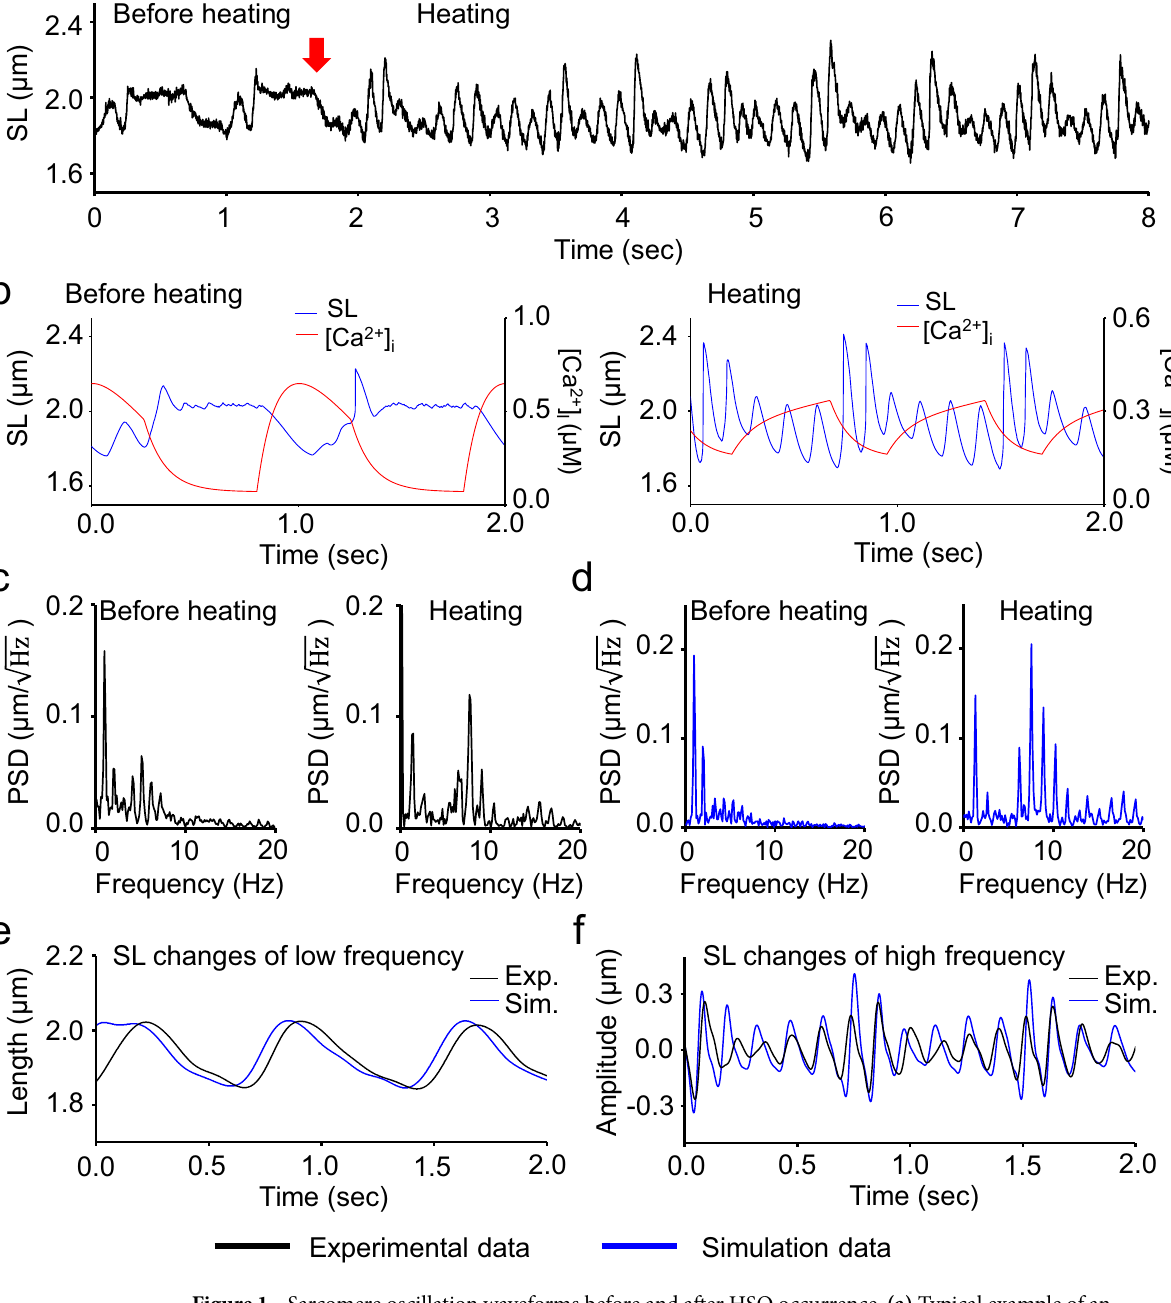
Figure 1. Sarcomere oscillation waveforms before and after HSO occurrence. (a) Typical example of an oscillation waveform of sarcomere length (SL) in cardiomyocytes. The infrared laser was activated at the time indicated by the red arrow. HSOs occurred promptly after irradiation. ( b) Simulation of the oscillation before (left panel) and after the temperature jump (right panel). ( c,d ) Power spectrum of a sarcomere oscillation waveform in the experiment (c) and in the simulation (d) before (left panels) and after the temperature jump (right panels). ( e,f) Sarcomere oscillations with frequency ranges of 0 to 3.5 Hz (e) and 3.5 to 25 Hz (f) . Black lines, experimental data; blue lines, simulation